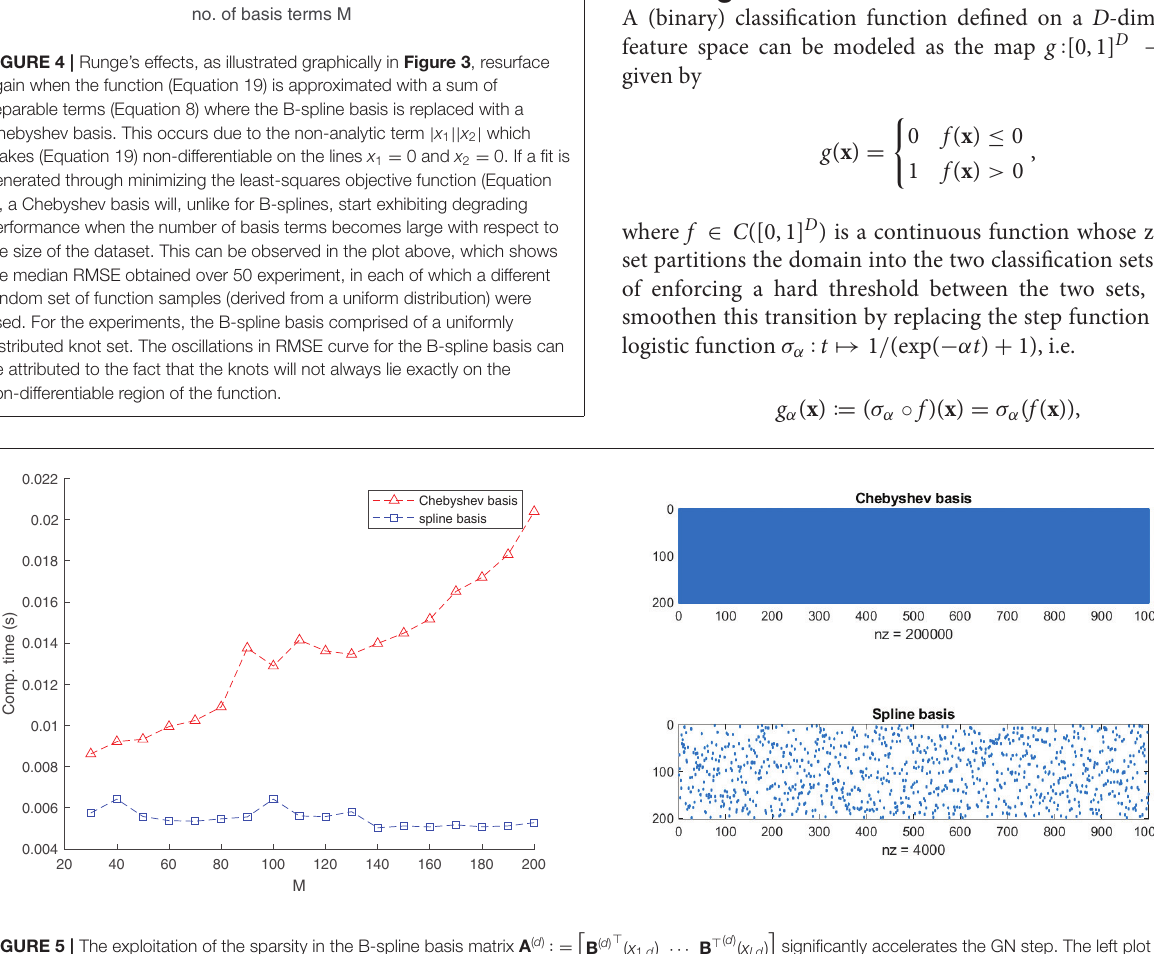
Frontiers in Big Data |